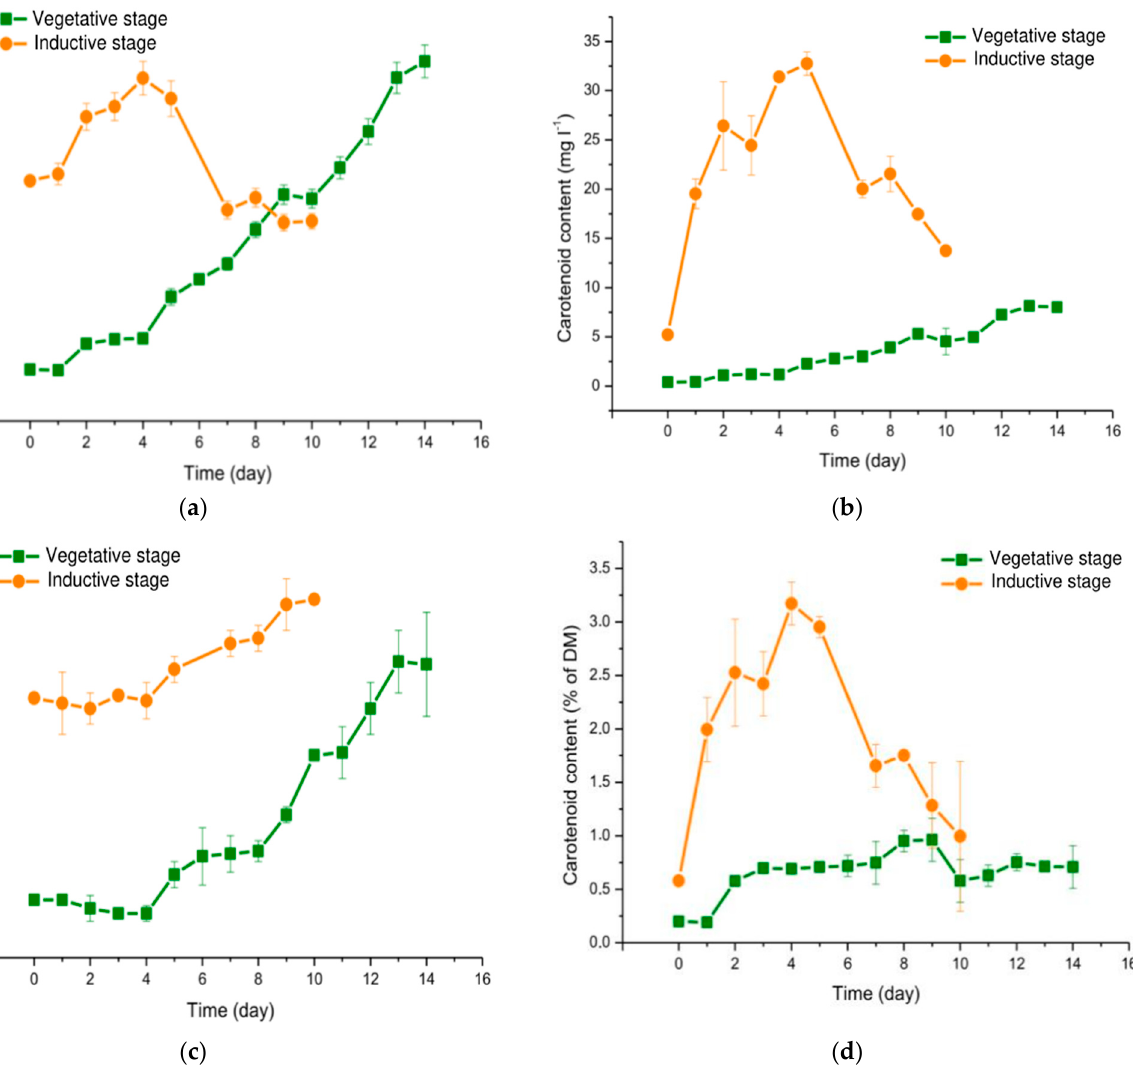
Figure 2. Growth parameters of the Bracteacoccus aggregatus BM5/15 (IPPAS С -2045) culture. Green curves, squares ( ⬛ ), correspond to vegetative growth stage. Orange curves, circles ( ● ), correspond to the inductive stage. ( a ) Dynamics of total chlorophyll content in the culture; ( b ) dynamics of total carotenoid content in the culture; ( c ) dynamic of cell dry weight in the suspension; ( d ) dynamics of carotenoid content in the algal biomass. The average values from three biological replicates and standard deviations are shown.